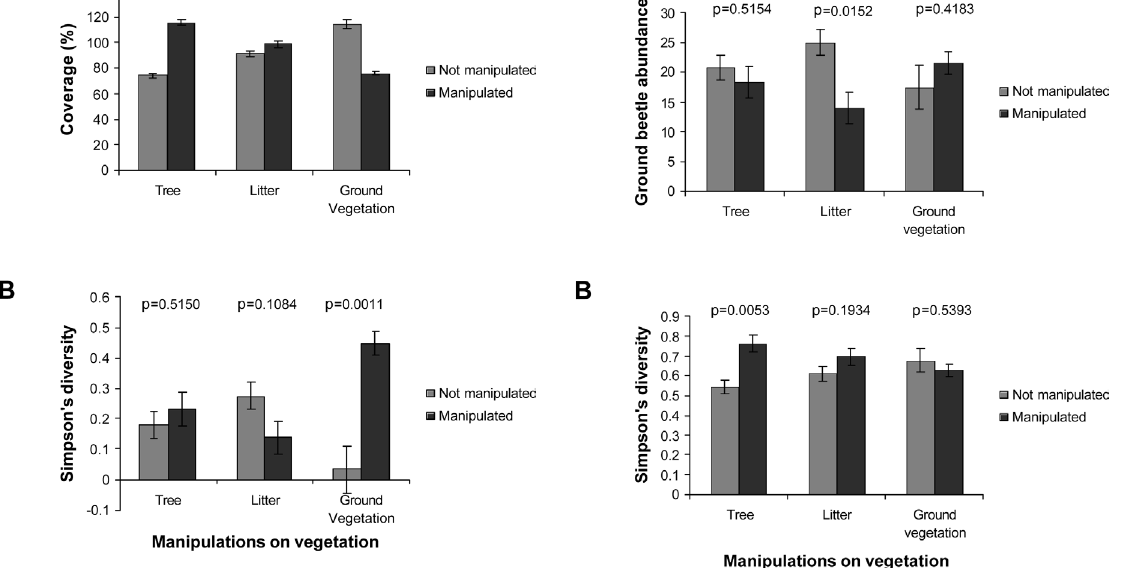
Fig. 2. The effects of disturbance type on regeneration of vegeta- tion in experimental plots. (A) coverage, (B) Simpson’s diversity, p-values are calculated using repeated-measures ANOVA. The error bars show ± 1 SE.